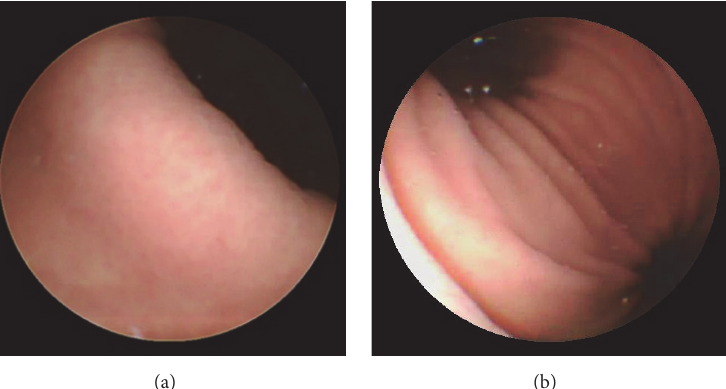
Figure 7: Angulus visualization from different positions. (a) Angulus visualization from Su position. (b) Angulus visualization from KC position. Su: supine; KC: